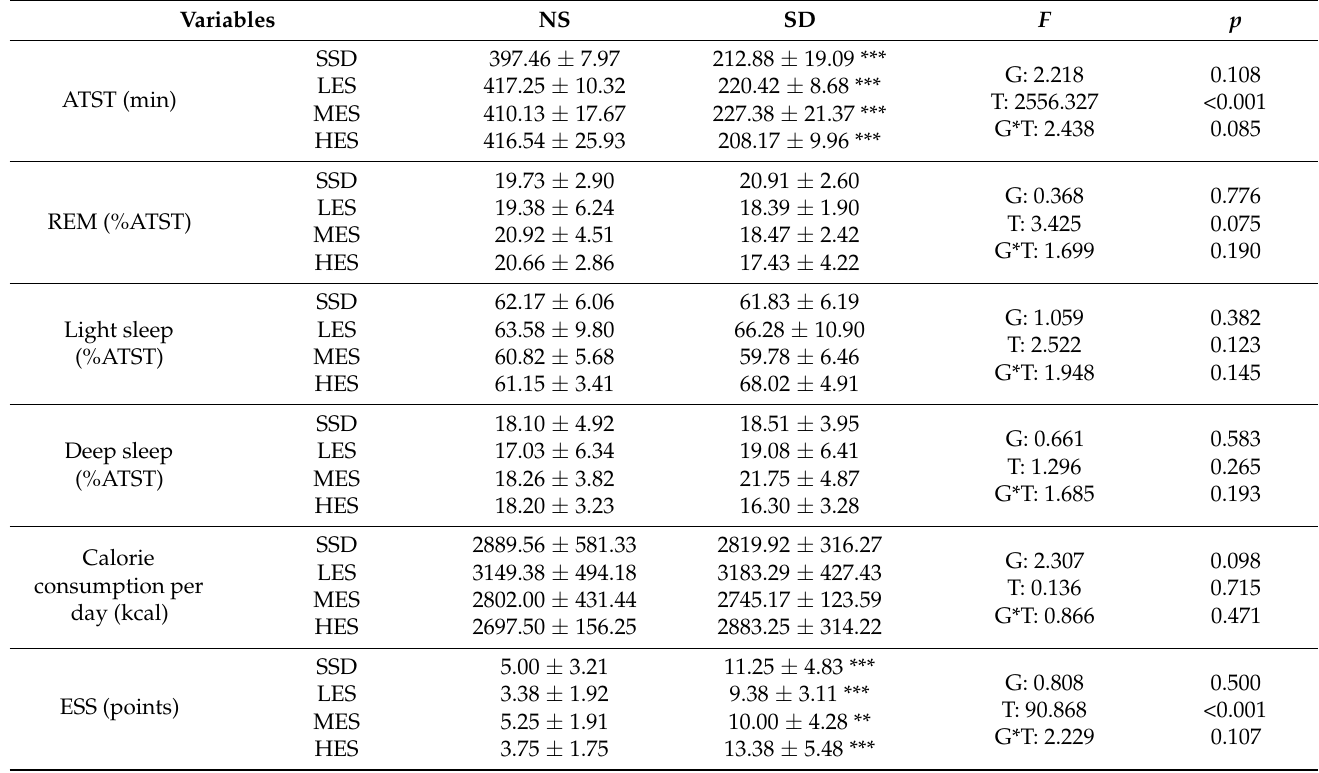
Table 2. The differences in sleep-related factors among